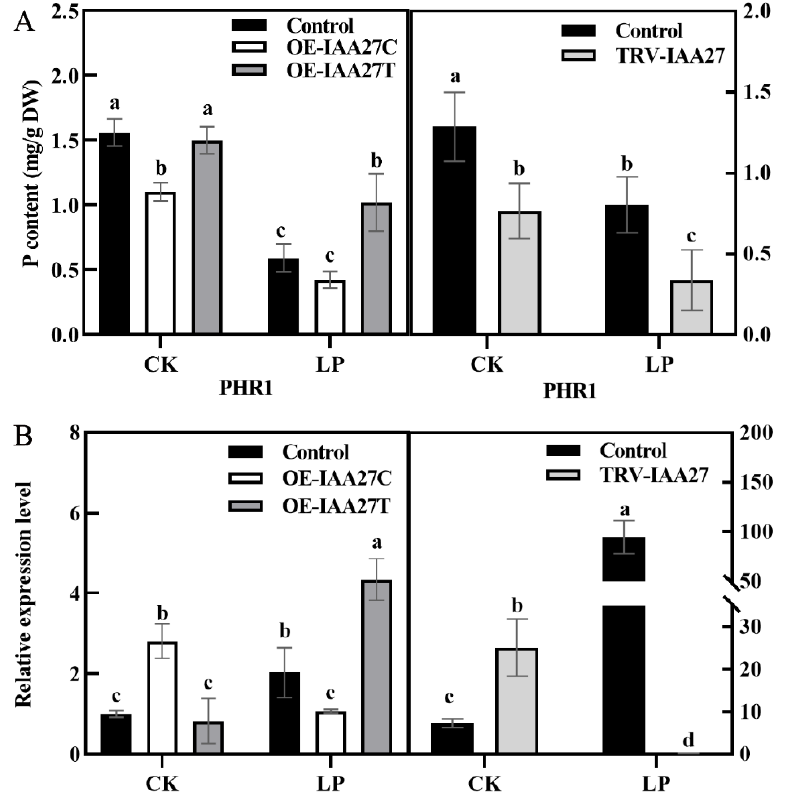
Figure 4. IAA27 influenced adventitious root development and P uptake. ( A ) The P content of roots in transgenic and control apples after low phosphorus treatment. ( B ) PHR1 expression was analyzed by qRT-PCR in MdIAA27 -overexpressed and -silenced ‘M9’ plants. Error bars indicate standard deviations (s.d.) from three biological replicates. Different letters represent significant differences ( p < 0.05) .